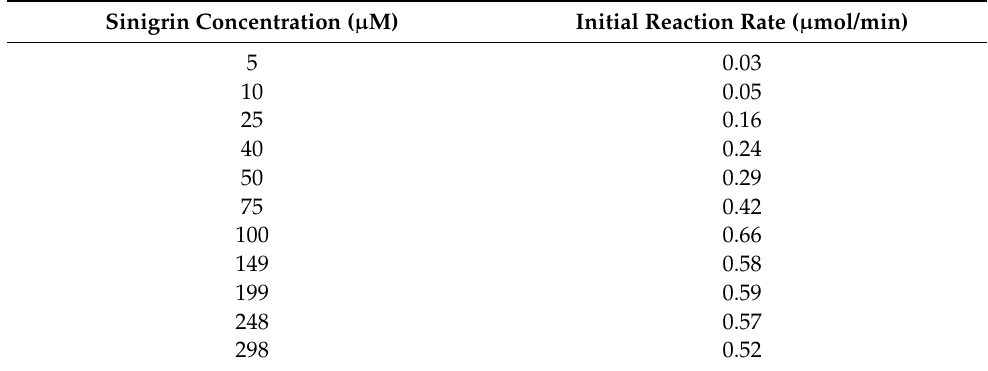
Figure S1: Model Fittings Results for All Participants, Matlab Codes and Simulink